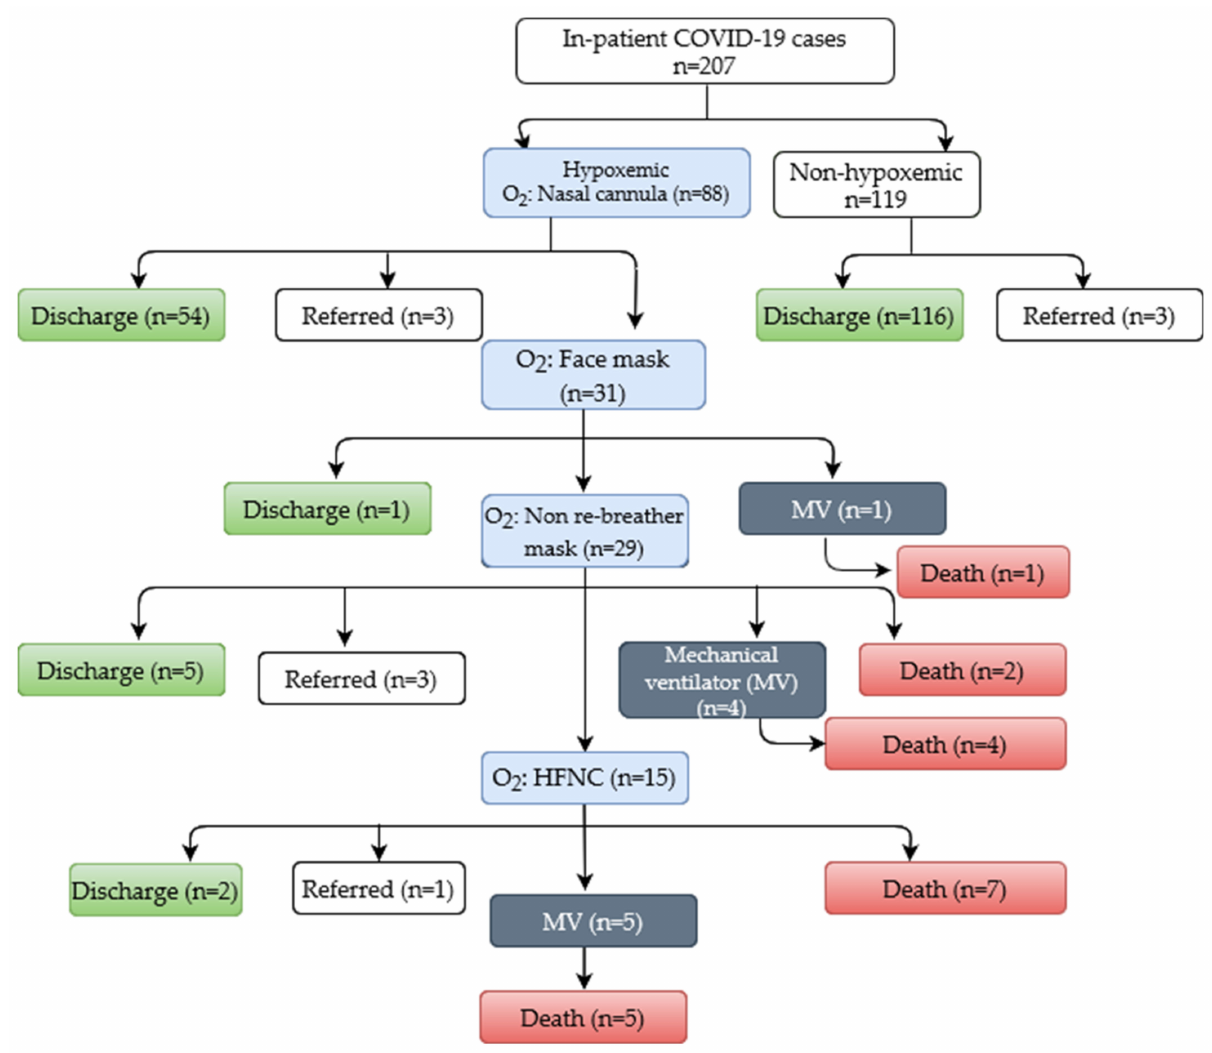
Figure 1. Flow diagram showing COVID-19 patients managed at icddr,b Dhaka